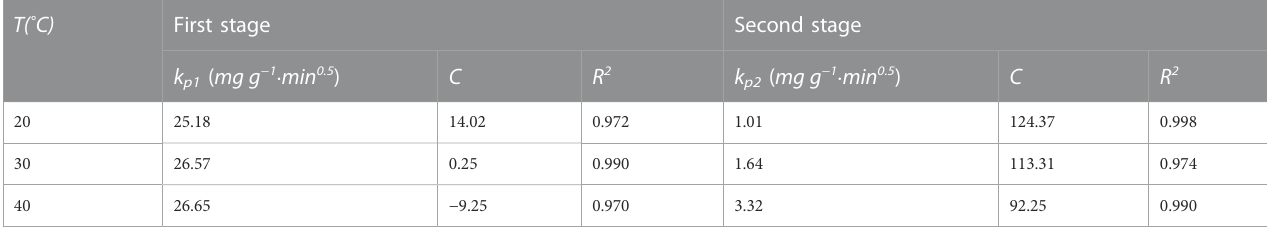
TABLE 4 Relevant parameters of particle diffusion model at different temperatures. T( ° C) First